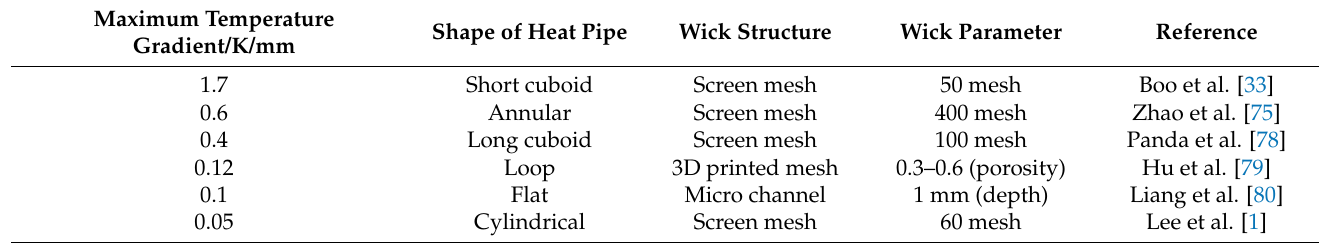
Table 6. Effect of the isothermal performance on different wicks of heat